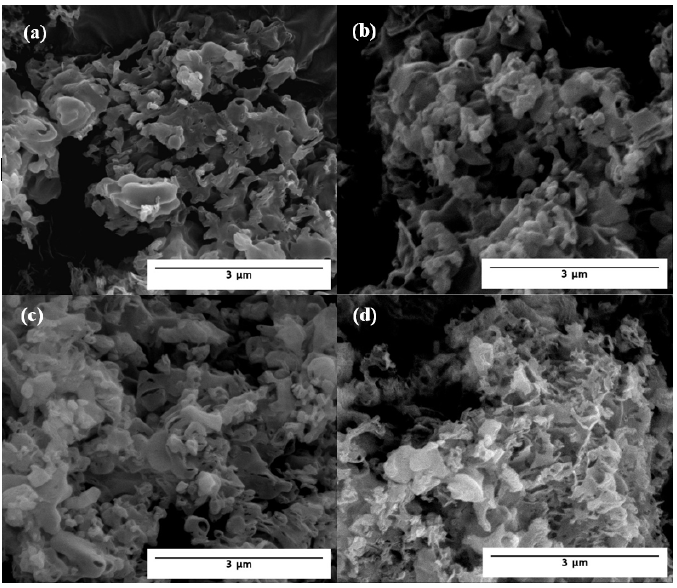
Figure 2. The SEM images of ( a ) pure g ‐ C 3 N 4 , ( b ) 0.5CDs/g ‐ C 3 N 4 , ( c ) 1.0CDs/g ‐ C 3 N 4 , and ( d ) 1.5CDs/g ‐ C 3 N 4 . (Magnification: 30,000×). ( d ) 1.5CDs/g-C 3 N 4 . (Magnification: 30,000 ×